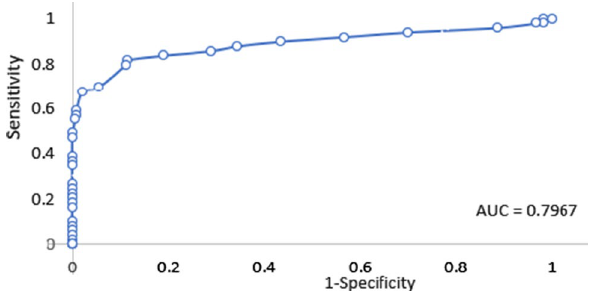
Fig. 6 ROC curve for the suitability map for SHP dam